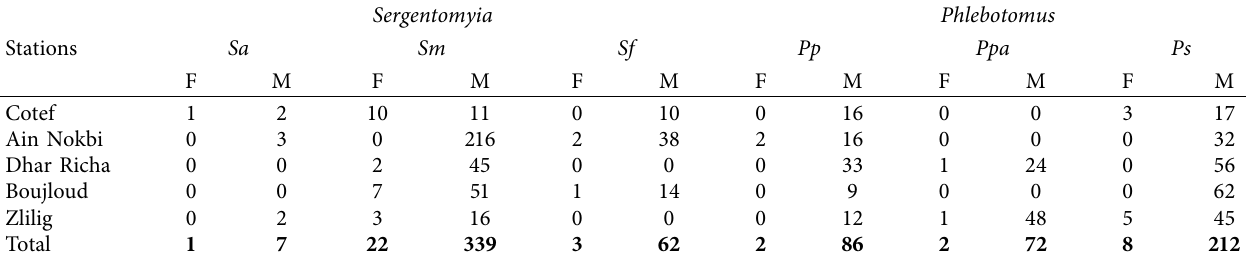
Table 2: Relative abundance of sand flies caught in different stations in the city of Fez, Morocco, from May 2016 to April 2017. Sergentomyia Stations